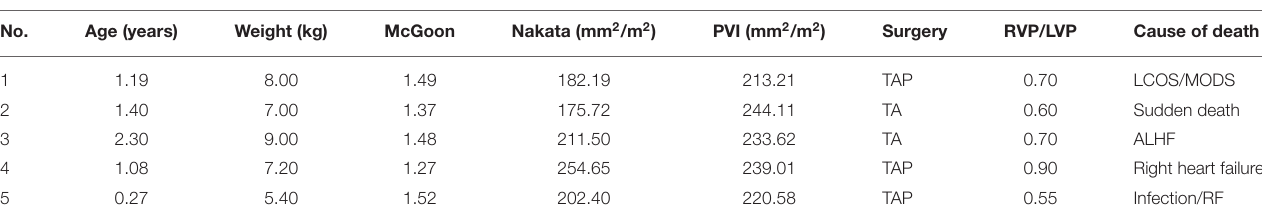
TABLE 3 | Summarize of early